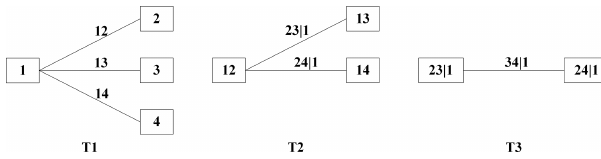
Figure 3. Decomposition of a C-vine copula using four variables and three trees (denoted by T1, T2, and